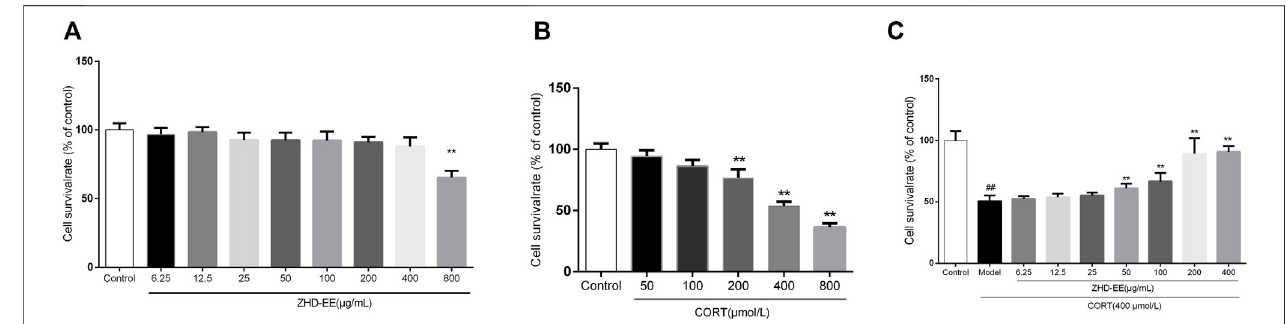
FIGURE 3 | The cell viability was measured by MTT assay. (A) : PC12 cells were exposed to different concentrations of ethanol extract of ZHD-EE (6.25, 12.5, 25, 50, 100, 200, 400, and 800 μ g · mL ‒ 1 ); (B) : PC12 cells were exposed to different concentrationsofCORT(50, 100, 200, 400, and 800 μ M) for 24 h; (C) : PC12 cells were exposed to different concentrations of ethanol extract of ZHD-EE (6.25, 12.5, 25, 50, 100, 200, and 400 μ g · mL ‒ 1 ) and 400 μ M CORT for 24 h. ## P < 0.01 vs. control group, **P < 0.01 vs. model group. ZHD-EE: ethanol extract of